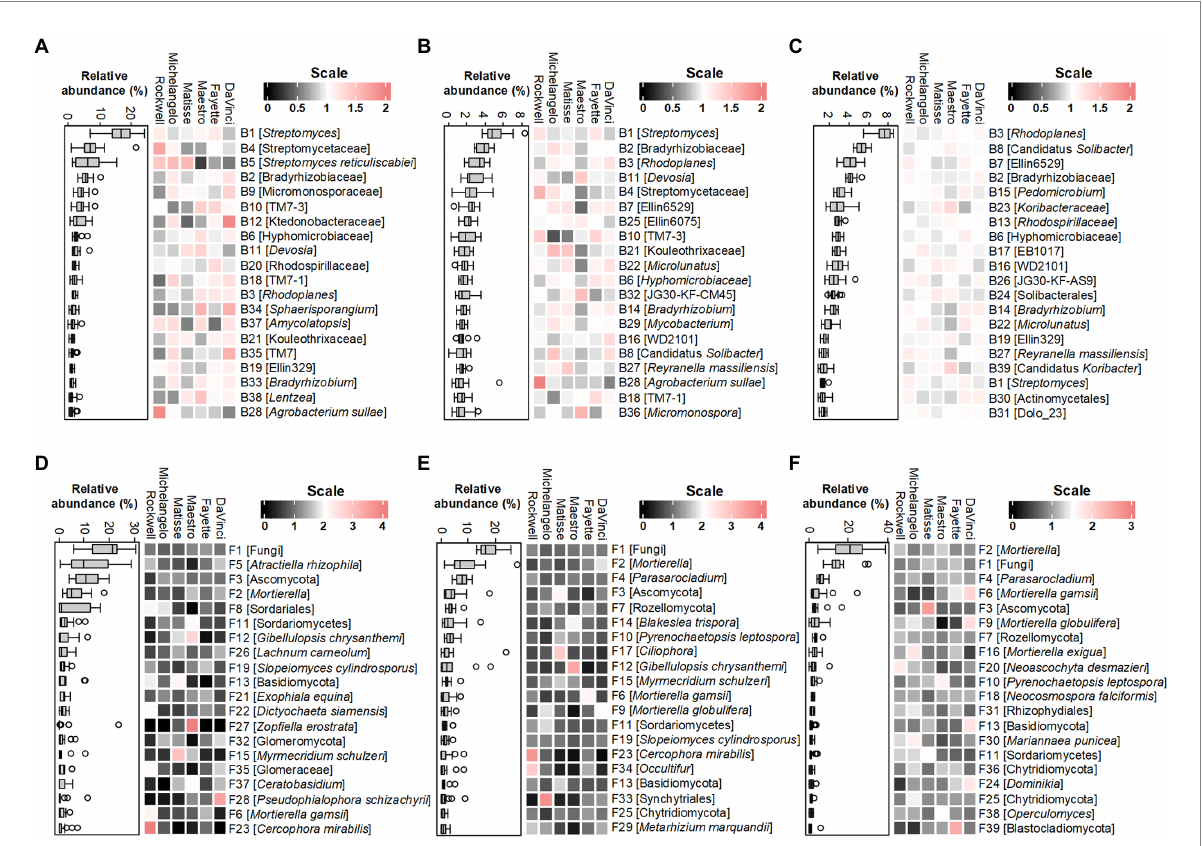
FIGURE 4 Heatmaps of normalized abundances of top 20 bacterial OTUs and fungal OTUs, respectively, in the root endosphere (A,D) , rhizosphere (B,E) and bulk soil (C,F) under no-irrigation. Normalization was made by dividing the relative abundance by the average value across six cultivars. Box plots represent the average values of relative abundances. The lowest-level taxonomic name of each OTU is shown in the square brackets. Complete taxonomic names are given in Supplementary Table